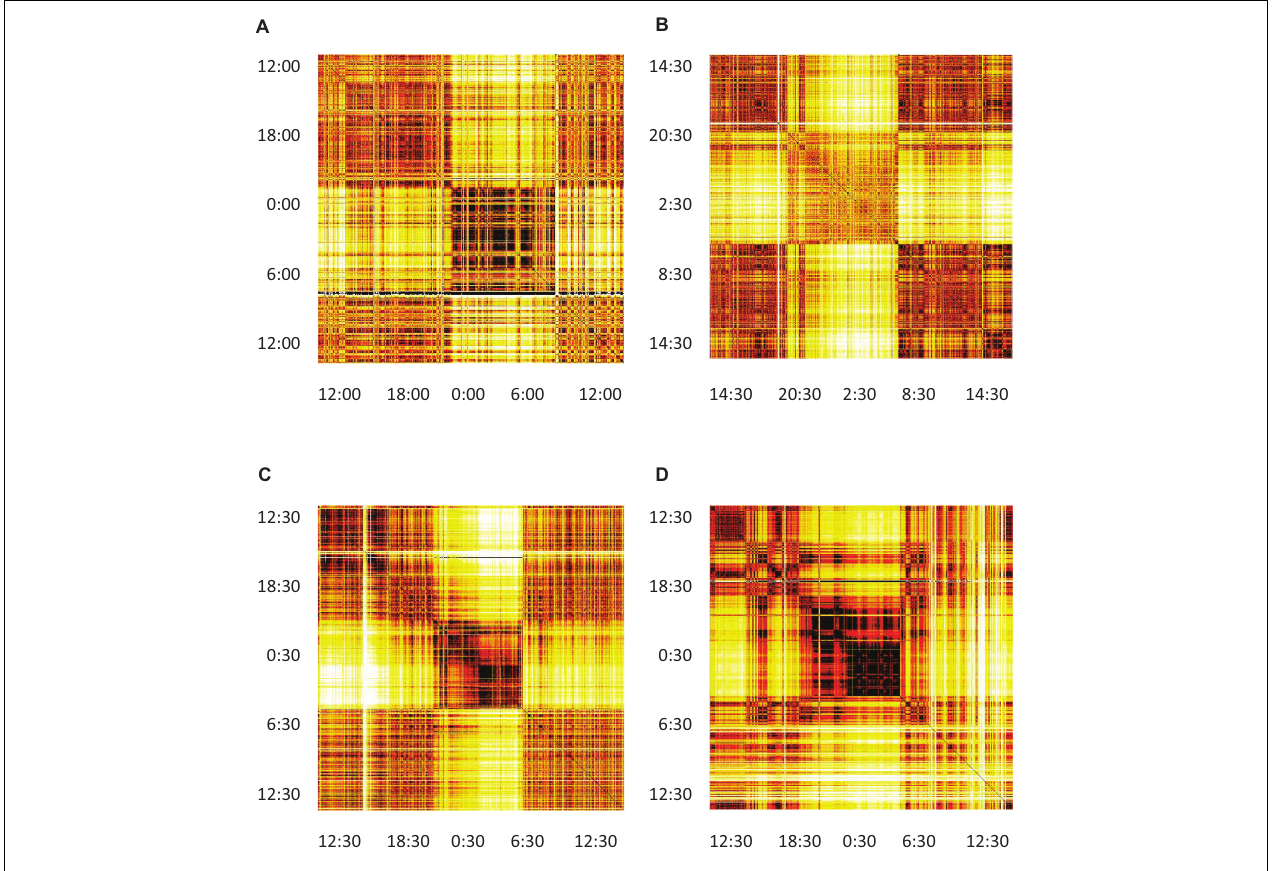
FIGURE 5 | Distance matrices for four selected subjects visualized as heat-maps. (A) Male subject, 21 years of age, (B) Female subject, 23 years of age. (C) Male subject, 49 years of age. (D) Female subject, 50 years of age. All matrices have 24 h of measurements indicated both horizontally and vertically. The color of each matrix element indicates the distance between the two segments, identifies as x and y coordinate of that matrix element (we neglect the asymmetry of this matrix, see section “Discussion” in the text). Darker colors represent shorter distances and brighter colors larger distances, so that darker cells indicate that two segments have similar heart activity, while brighter colors connect segments with different heart activity. It can be noted that sleep shows more self-similarity than awake.